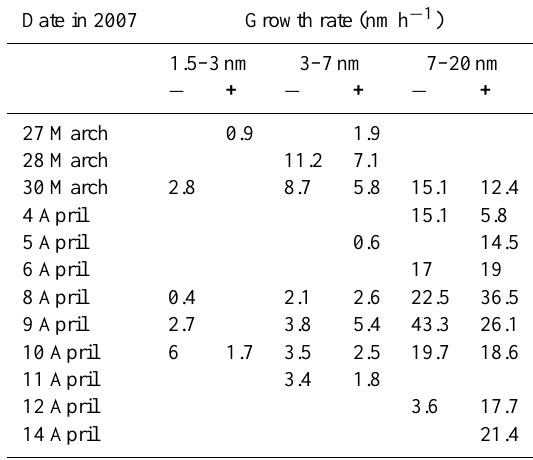
Table 1. Nucleation mode particle growth rates (GRs) calculated from the SMPS data.